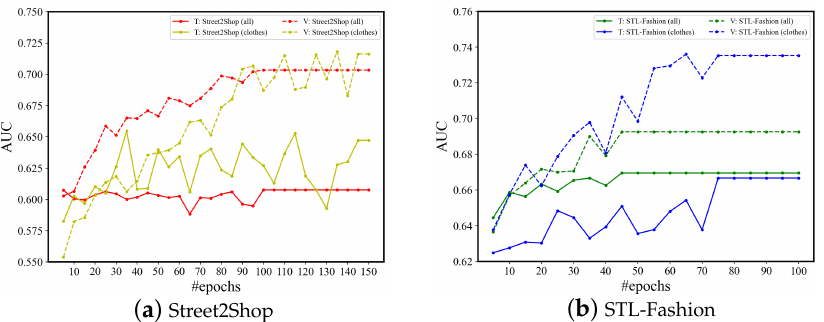
Figure 16. Training epochs on Street2Shop and STL-Fashion datasets for a non-label-given